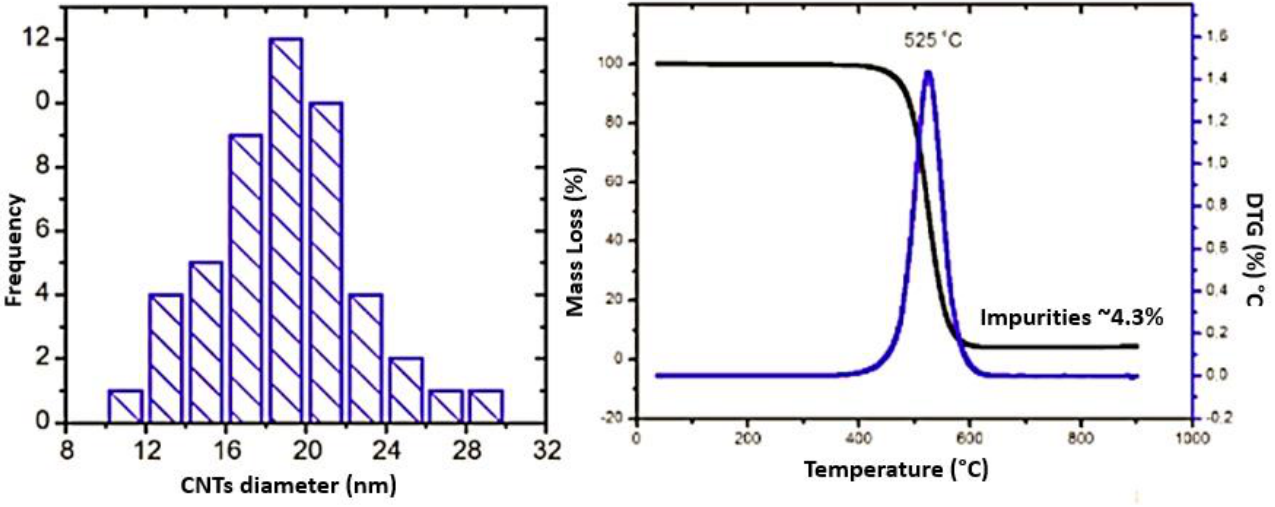
Figure 2. Characterization of dimensions and purity information of the CNTs, provided by the supplier.